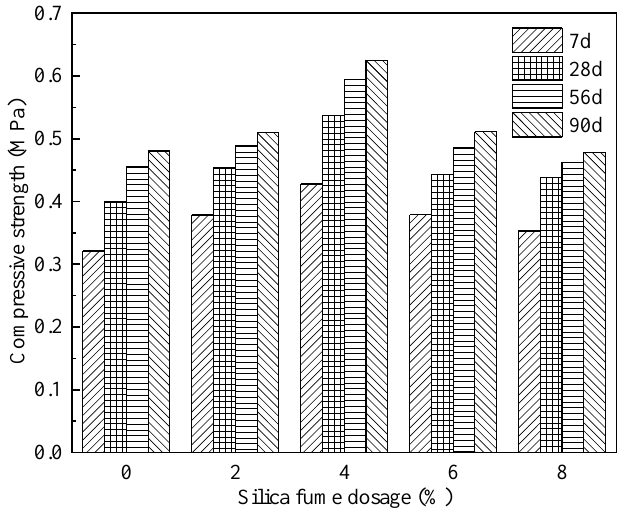
Figure 5. Effect of silica fume on compressive strength at different ages.